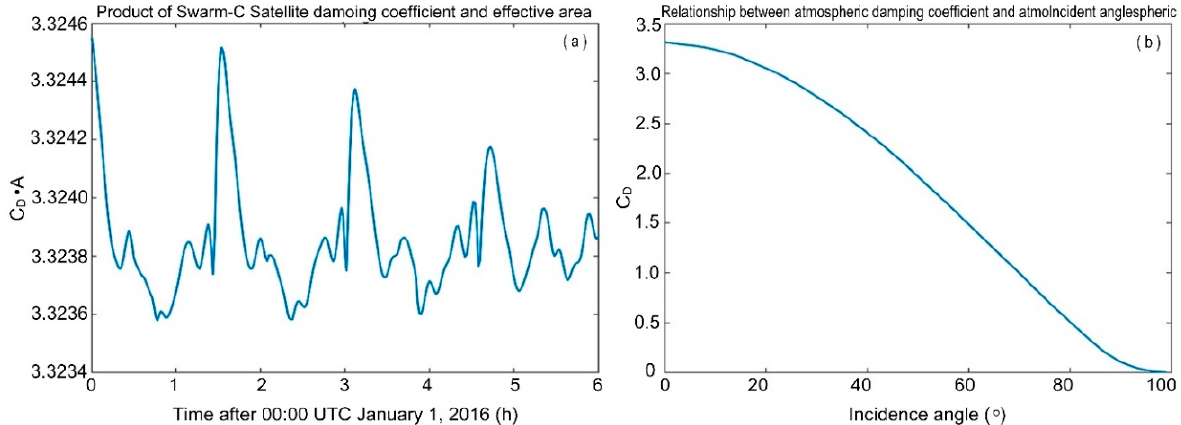
Figure 9. The Swarm-C satellite coefficient relationships. ( a ) Swarm-C satellite drag coefficient and effective area product; ( b ) atmospheric drag coefficient versus angle of incidence of gas molecules.